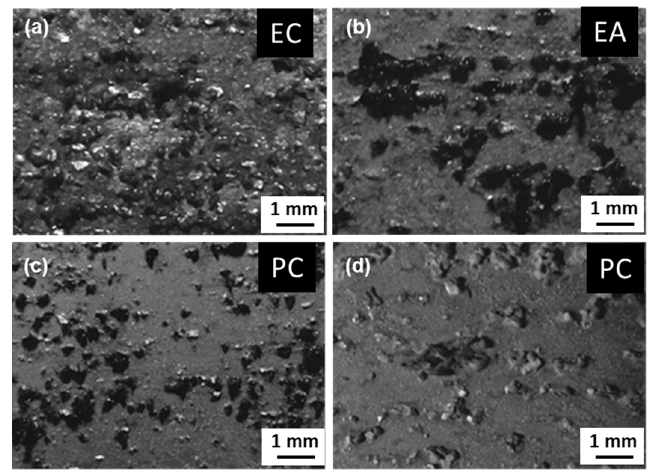
Figure 7. Results of EXCO evaluations after exposed for 12 h: ( a ) Ce-free alloy at T6 temper; ( b ) Ce-containing alloy at T6 temper; ( c ) Ce-containing alloy at T7 temper; ( d ) Ce-containing alloy at RRA temper.